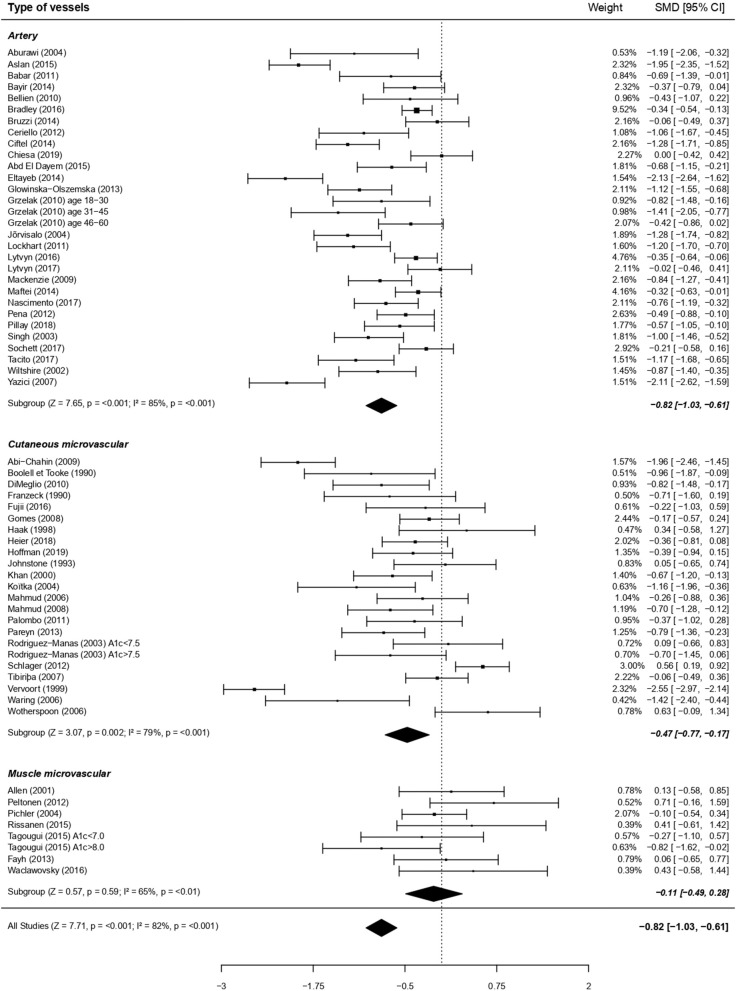
Forest plots of studies on endothelial function, according to types of vessels studied, in subjects with type 1 diabetes vs. controls. For each subgroup, the following values are indicated: Z and p-value; I2, heterogeneity and p for heterogeneity. When comparing the three vessels types with metaregressions (for qualitative data), the difference was significant (moderator P = 0.005), with a greater dysfunction for artery compared to muscle microvessels (post-hoc comparison using Bonferroni correction, p < 0.05) and a tendency for a greater dysfunction at artery compared to cutaneous microvessels (post-hoc comparison using Bonferroni correction, P = 0.09).